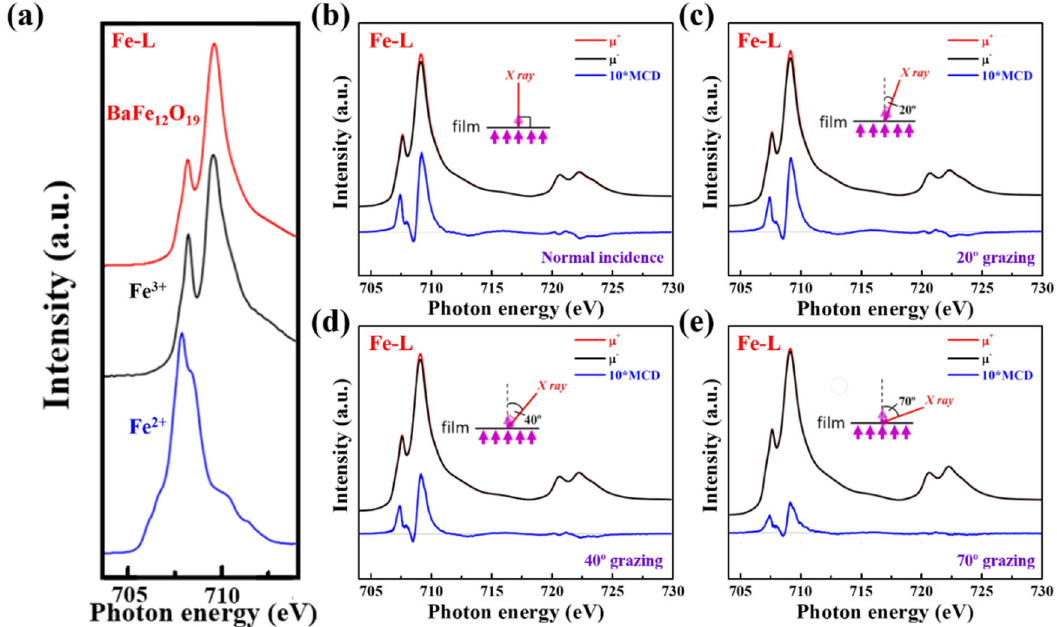
Fig. 3 XAS-XMCD measurements. a XAS of BaM fi lm, reference Fe 2 O 3 (Fe 3 + ), and reference Fe 0.04 Mg 0.96 O (Fe 2 + ) at Fe L 3 edge taken at room temperature. XAS and corresponding XMCD at Fe L 2,3 edge of BaM fi lm measured by incident x-ray at four different grazing angles b Normal 0°, c 20°, d 40°and e 70°.